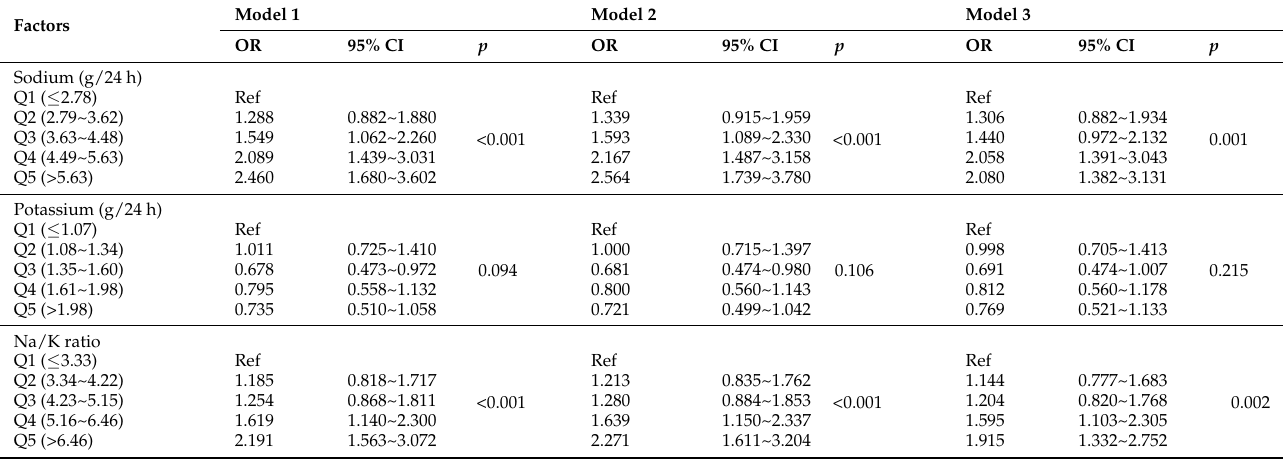
Table 4. Sensitivity analysis-Odds ratio (OR) and 95% confidence interval of albuminuria at each quintile of urinary index using mixed effects logistic regression